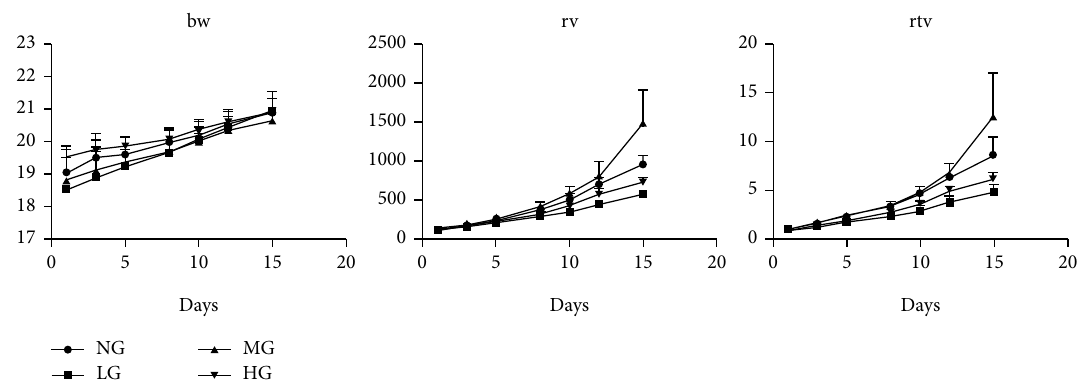
Figure 12: The reducing e ff ect of cervical recipe on tumor weight and